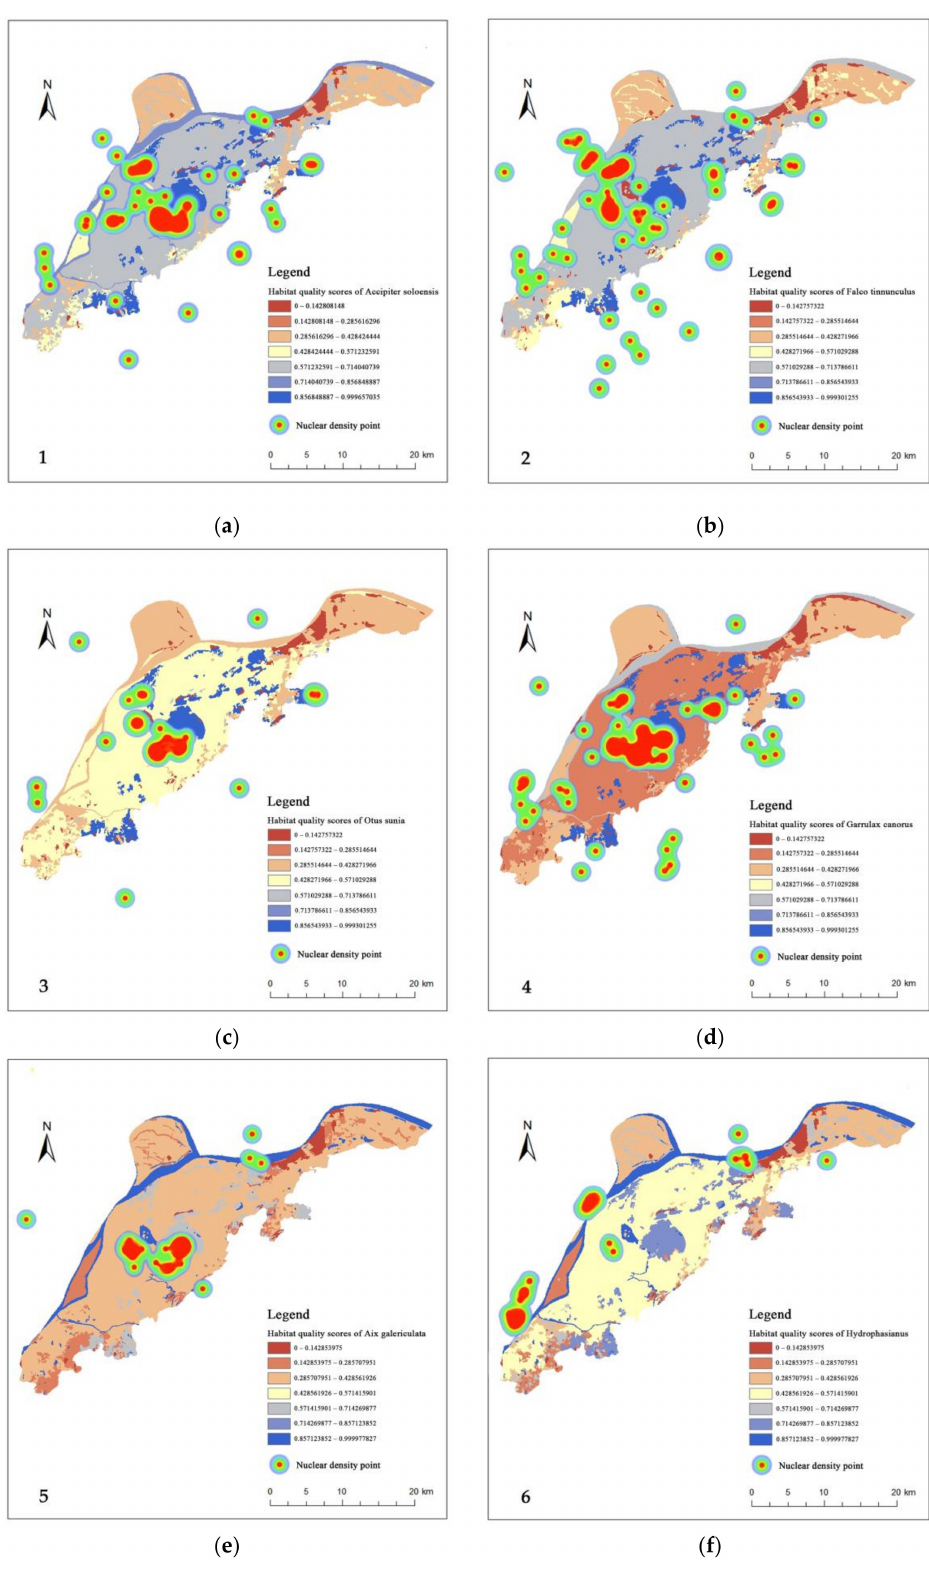
Figure 2. Habitat quality assessment results and nuclear density maps of six bird species: ( a ) Ac- cipiter soloensis ; ( b ) Falco tinnunculus ; ( c ) Otus sunia ; ( d ) Garrulax canorus ; ( e ) Aix galericulata ; ( f ) Hy- drophasianus chirurgus